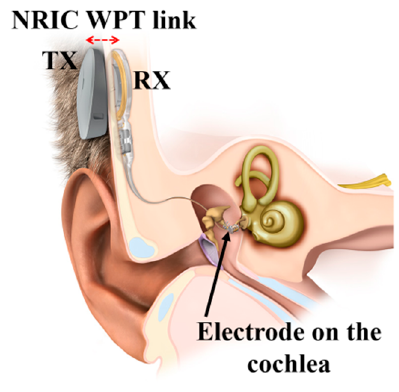
Figure 19. MED-EL cochlear implant NRIC WPT link. Adopted with permission from